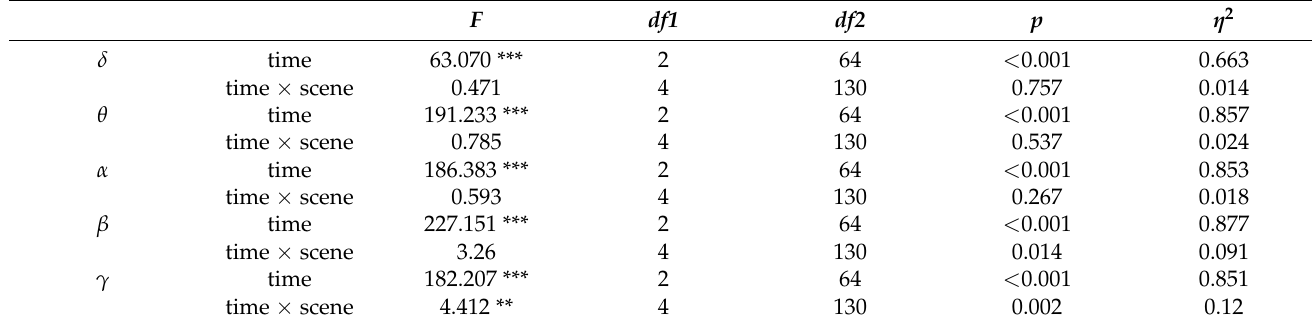
Table A6. Results of multivariate test of PSD in each frequency band.